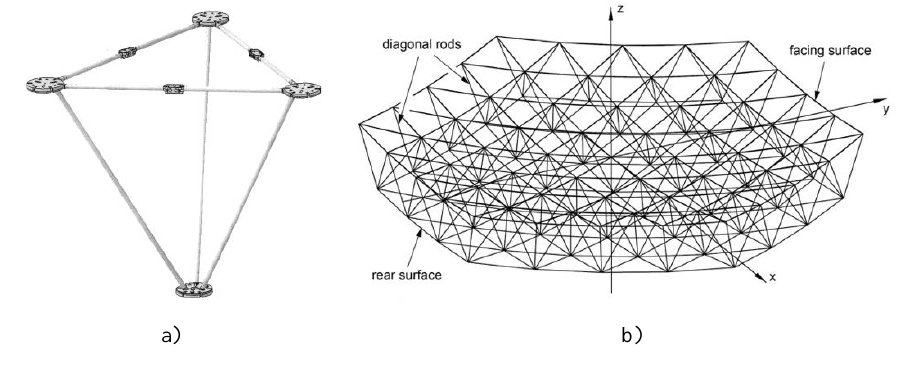
Fig. 6. Truss reflector